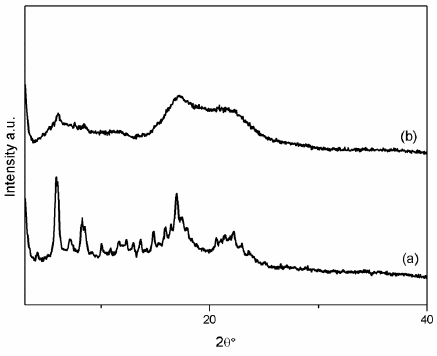
Figure 2. X-ray diffraction patterns of the pure ethanol-treated cyclodextrin ( a ) and of the VC-IP@cyclodextrin sample ( b ).